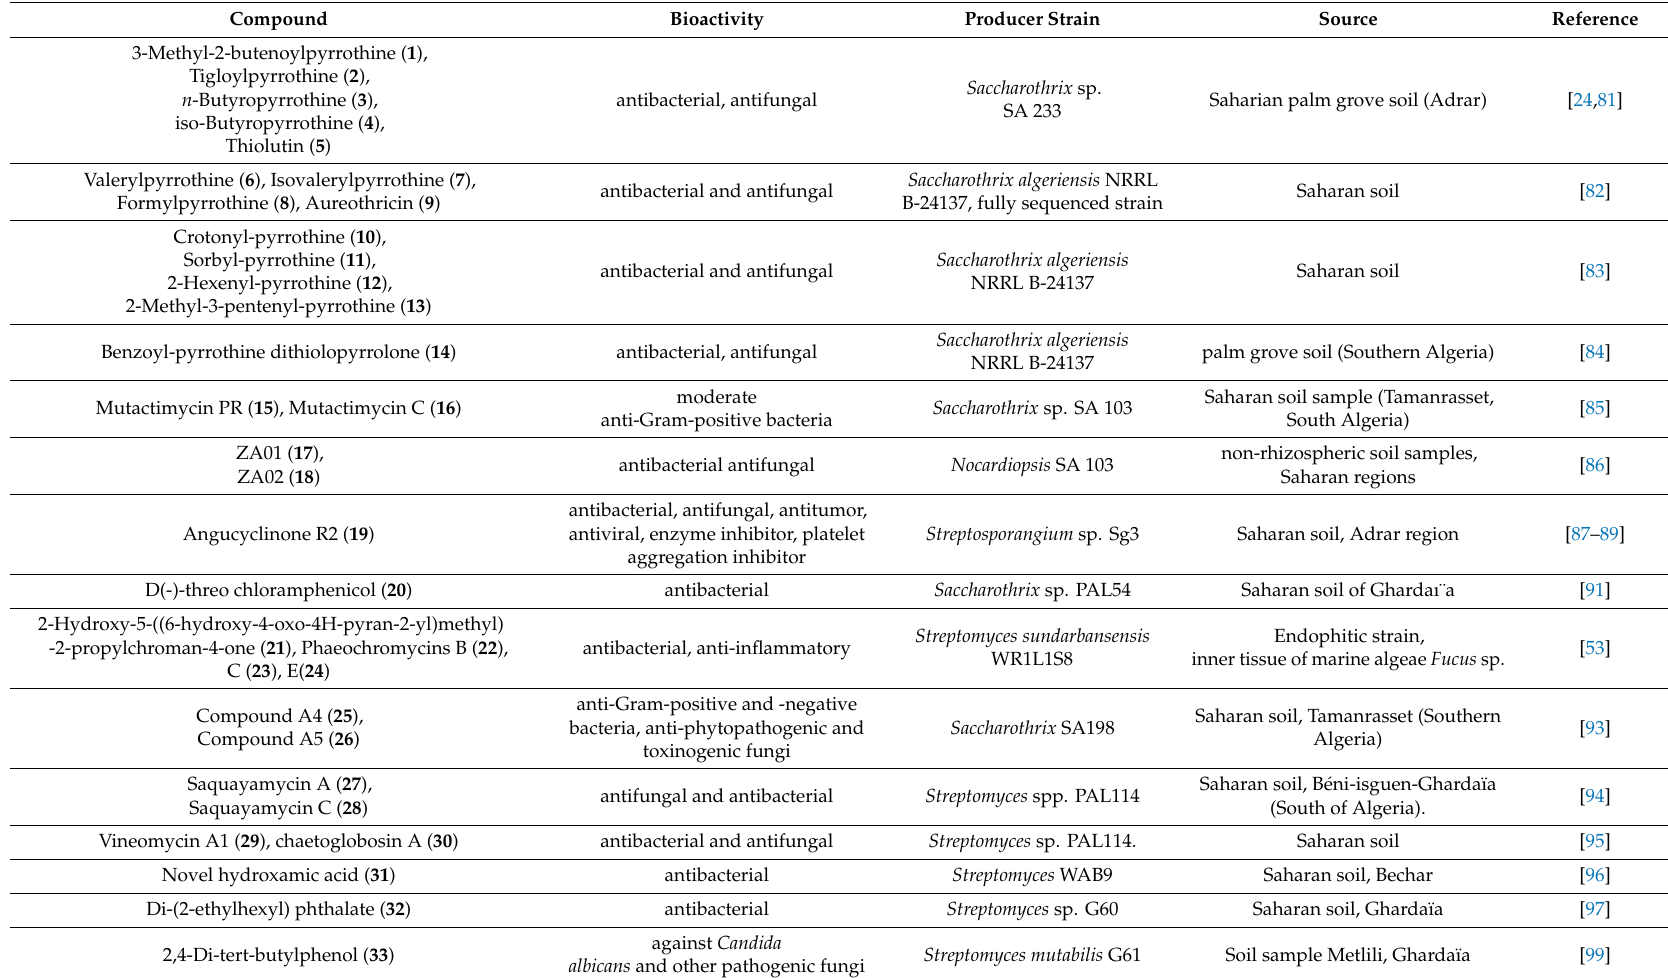
Table 2. Bioactivities of Actinobacteria metabolites derived from Algerian